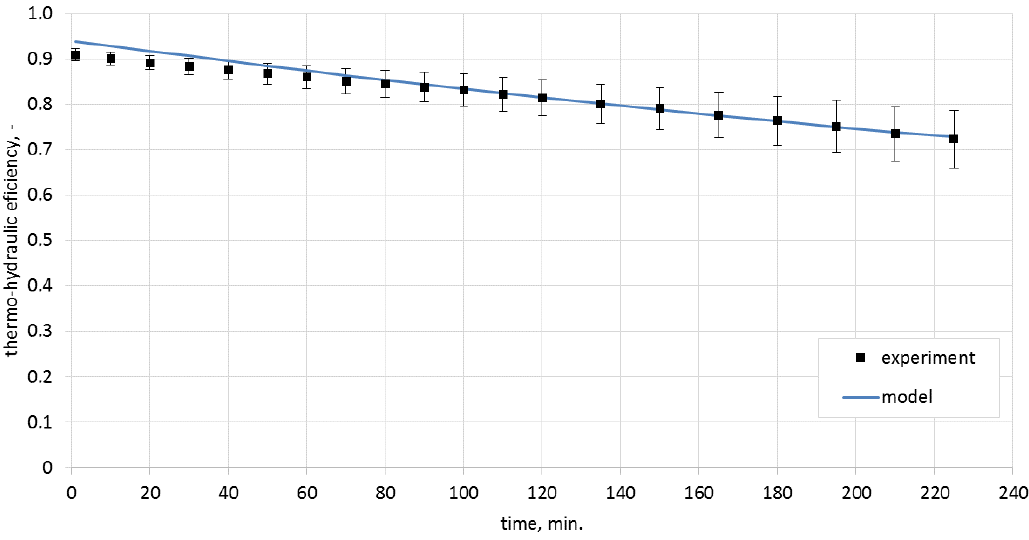
Materials 2017 , 10 , 940 Figure 8. Thermo-hydraulic efficiency for the airflow rate of 0.0050 m 3 /s. Figure 8. Thermo-hydraulic efficiency for the airflow rate of 0.0050 m 3 /s.